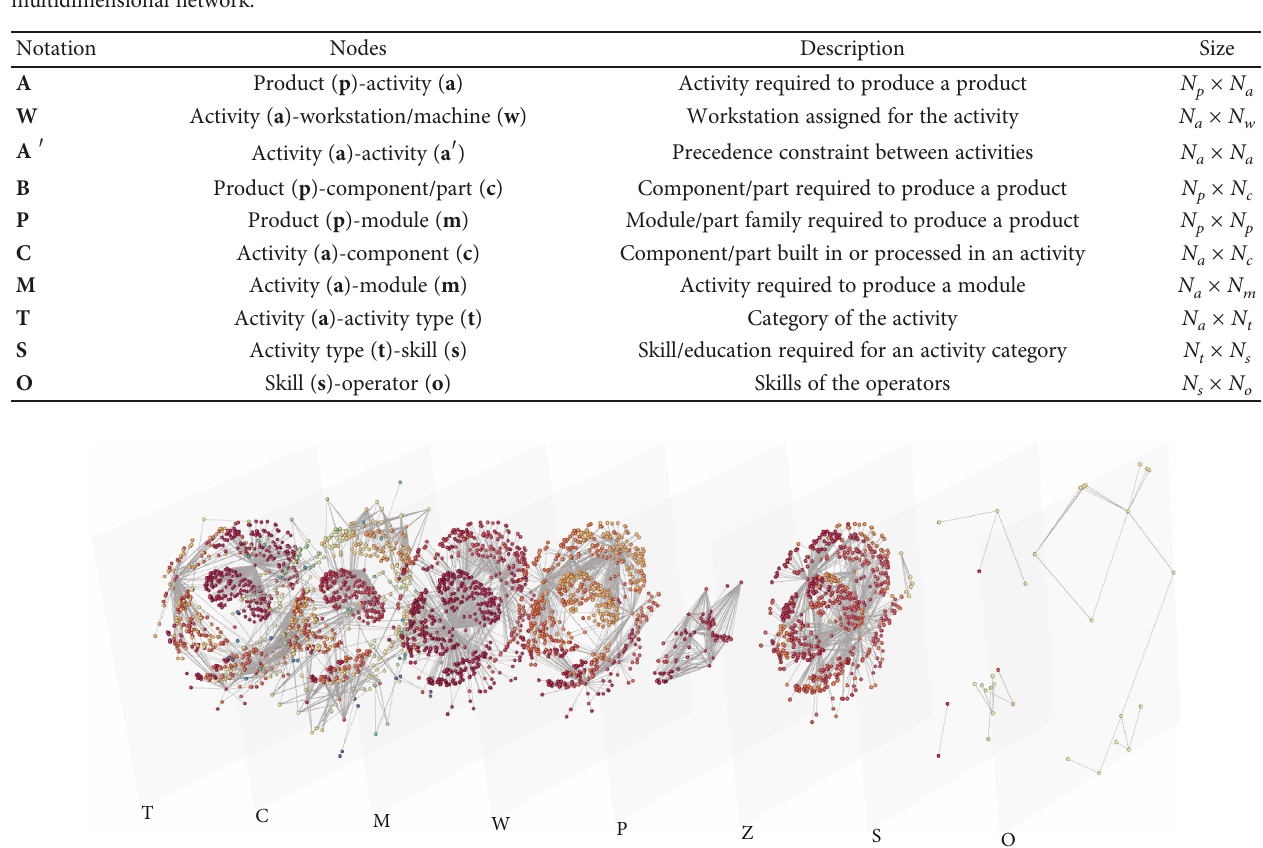
Table 1: De fi nition of the biadjacency matrices of the bipartite networks used to illustrate how a production system can be represented by a multidimensional network.